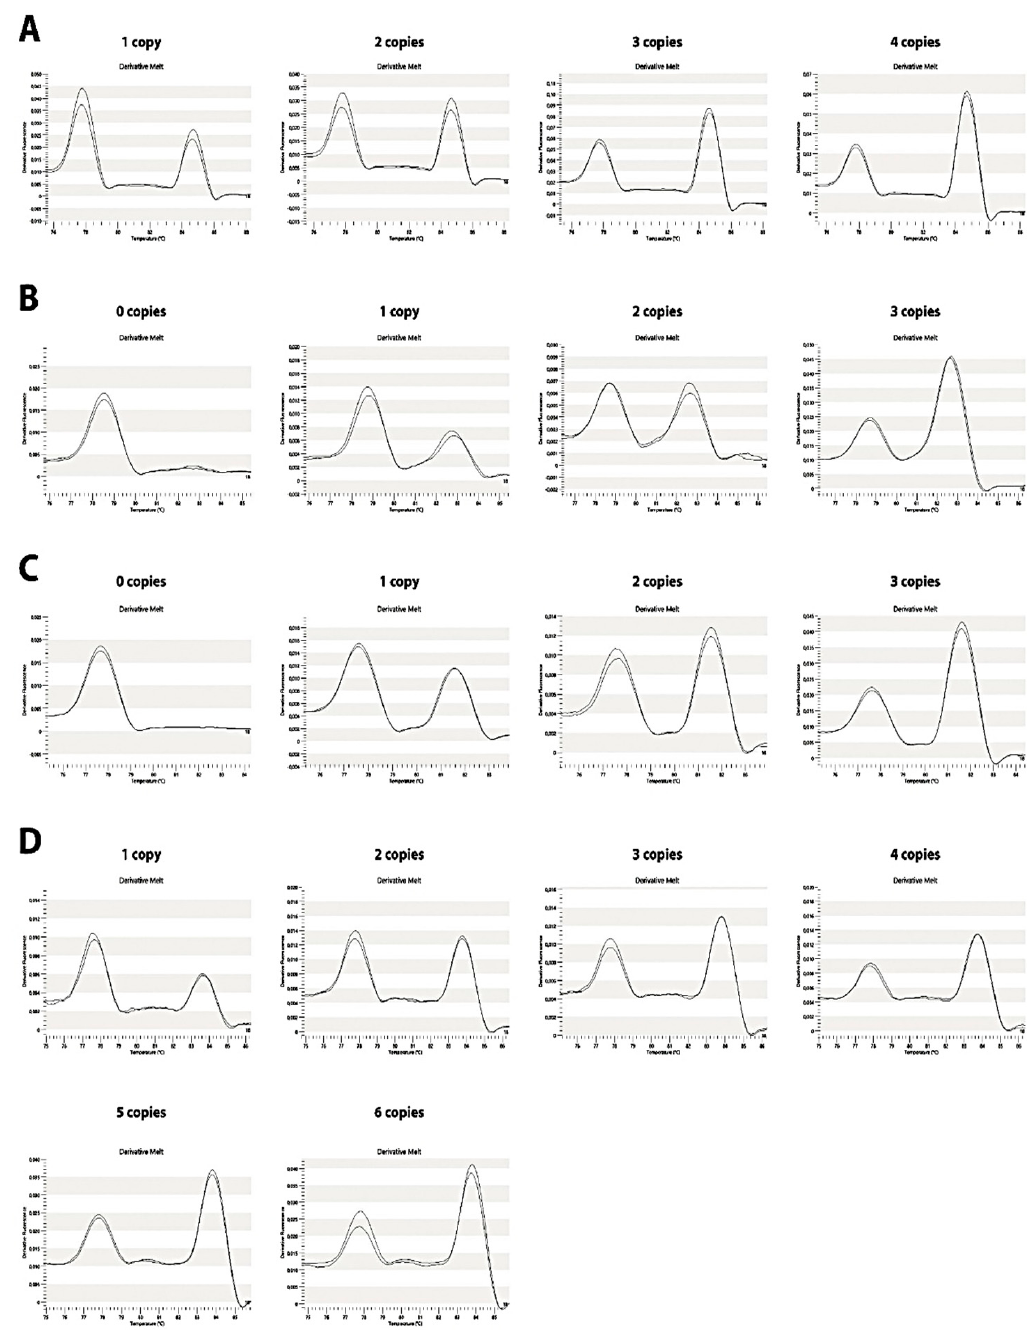
Figure 4. Pattern for C4 genes copy number. ( A ) C4A , ( B ) C4B , ( C ) C4S and ( D ) C4L genes. Peak height (-dF / dT) versus temperature plots, relative to the reference gene. The melting plots are proportional to the copy number of each gene.